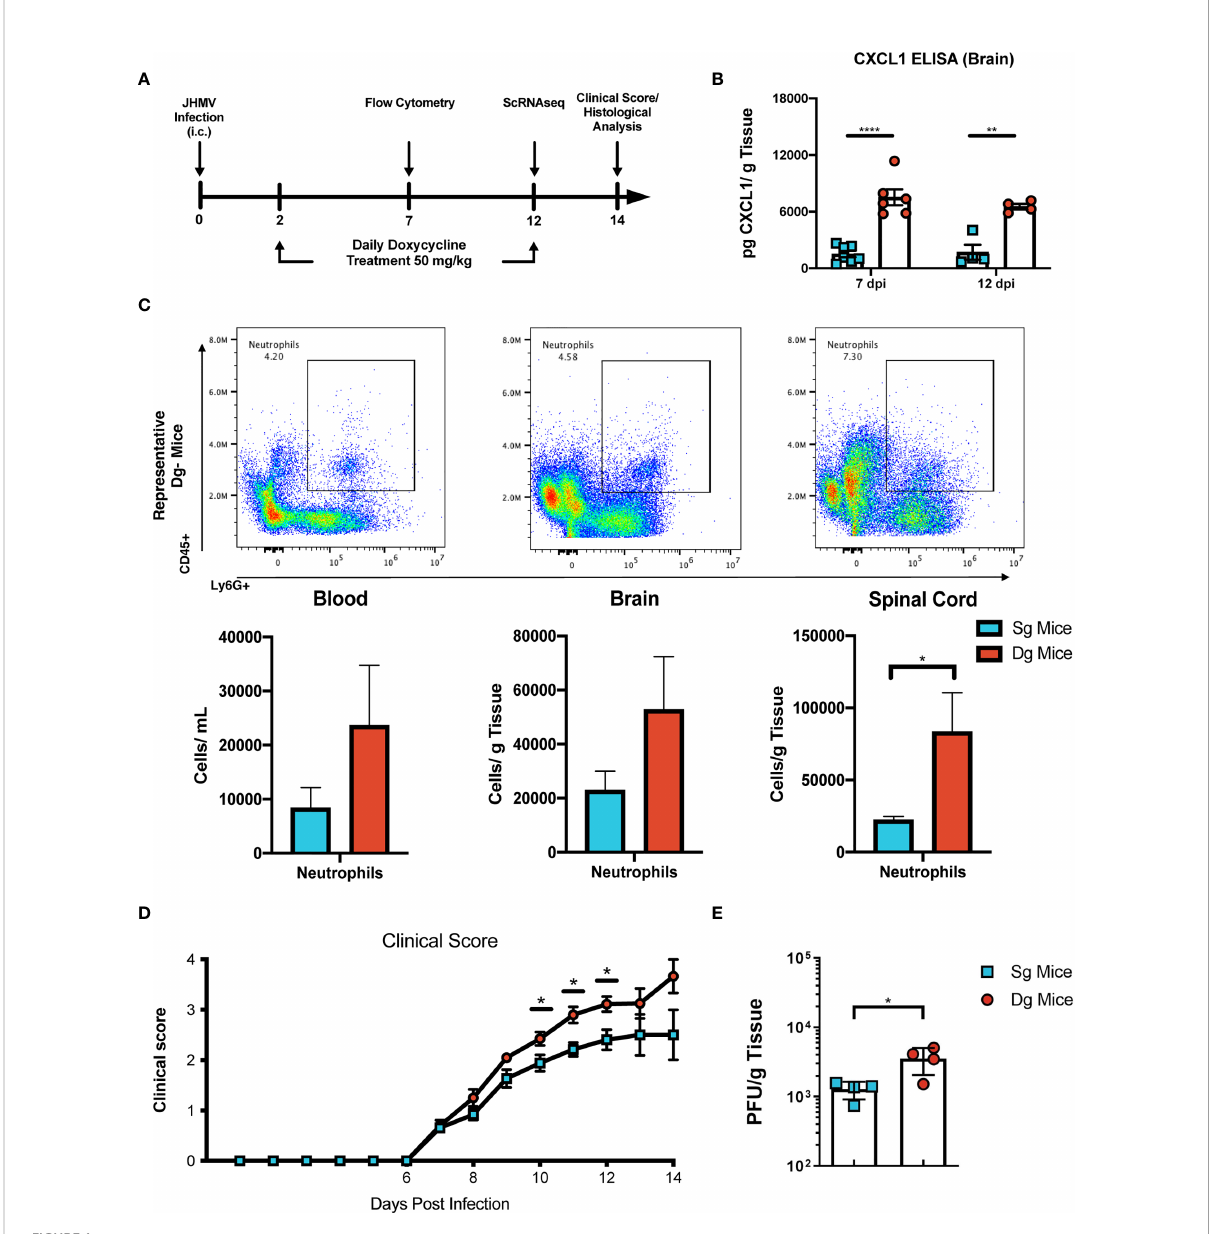
FIGURE 1 JHMV-infection of double-tg mice results in worsened clinical disease following doxycycline-induced CXCL1 expression. (A) Schematic overview showing experimental paradigm. Single-tg and double-tg mice were infected intracranially (i.c) with 250 PFU of JHMV and treated daily with doxycycline (50 mg/kg) via i.p. injection from 2-12 days p.i. Tissue was collected and analyzed at de fi ned times. (B) ELISA was performed using supernatants of homogenized infected brain tissue at days 7 (n = 6-7 mice per group) and 12 (n = 4 mice per group) p.i.; double-tg mice showed elevated levels of CXCL1 protein at both timepoints following doxycycline treatment compared to single-tg control mice. Data is derived from a minimum of 2 independent experiments per timepoint. (C) Flow cytometry dot plots showing increased neutrophil (CD45+Ly6G+) accumulation in the blood, brain and spinal cords of double-tg mice compared to single-tg control. Data is derived from 2 independent experiments with a minimum of 5 mice used per tissue type. (D) Representative clinical disease showing JHMV-infected double-tg (n = 5) with increased (p < 0.05) clinical disease severity compared to infected single-tg mice (n = 6) at de fi ned times p.i. (E) Viral titers are increased (p < 0.05) within the brains of JHMV-infected double-tg mice (n = 4) compared to infected single-tg mice (n = 4) at day 12 p.i. at day 12 p.i. *p < 0.05, **p < 0.01, ****p <